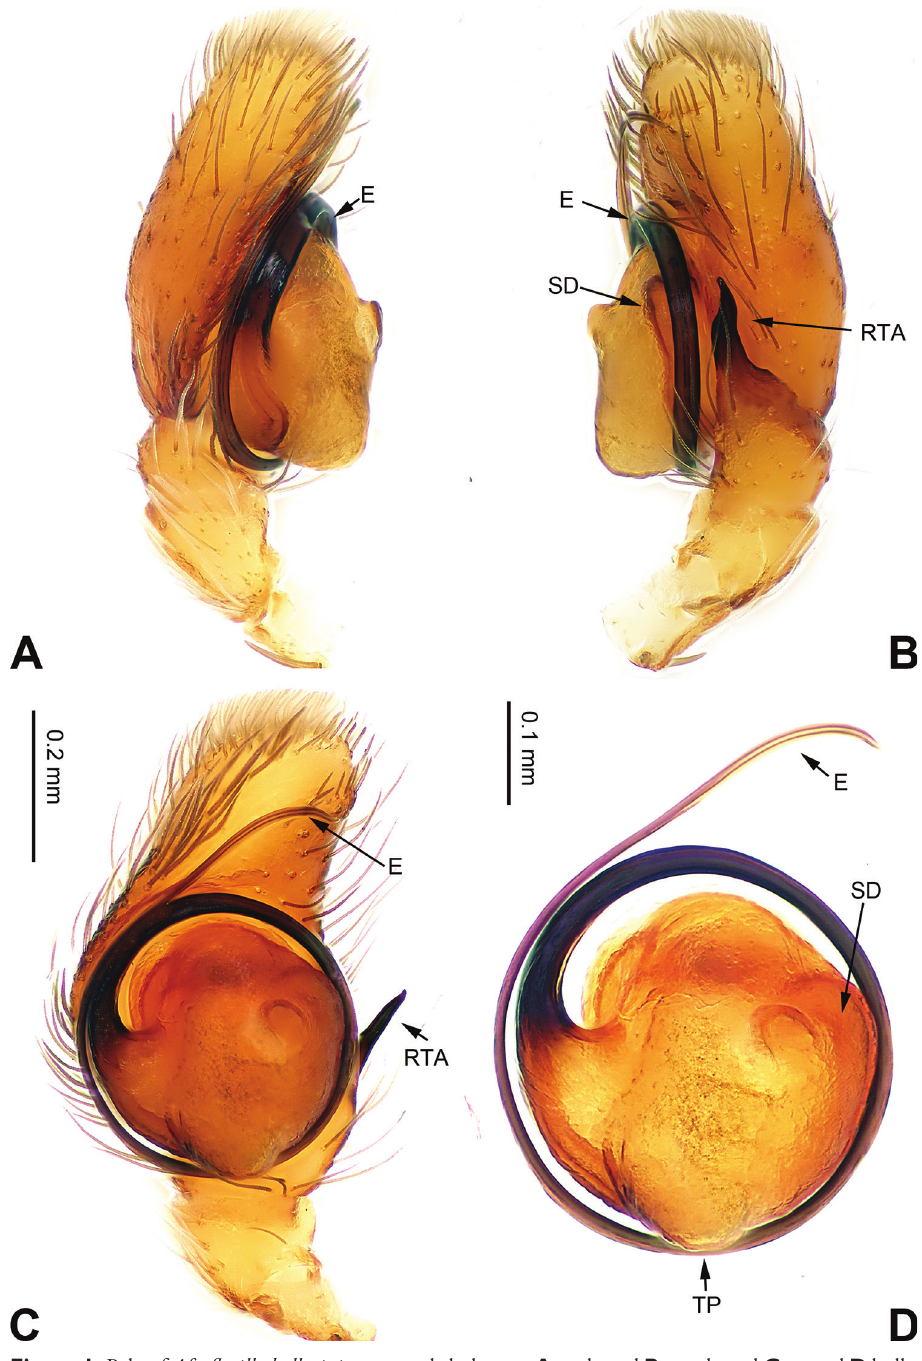
Figure 1. Palp of Afraflacilla ballarini sp. n., male holotype. A prolateral B retrolateral C ventral D bulb, ventral. Scale bar equal for A–C